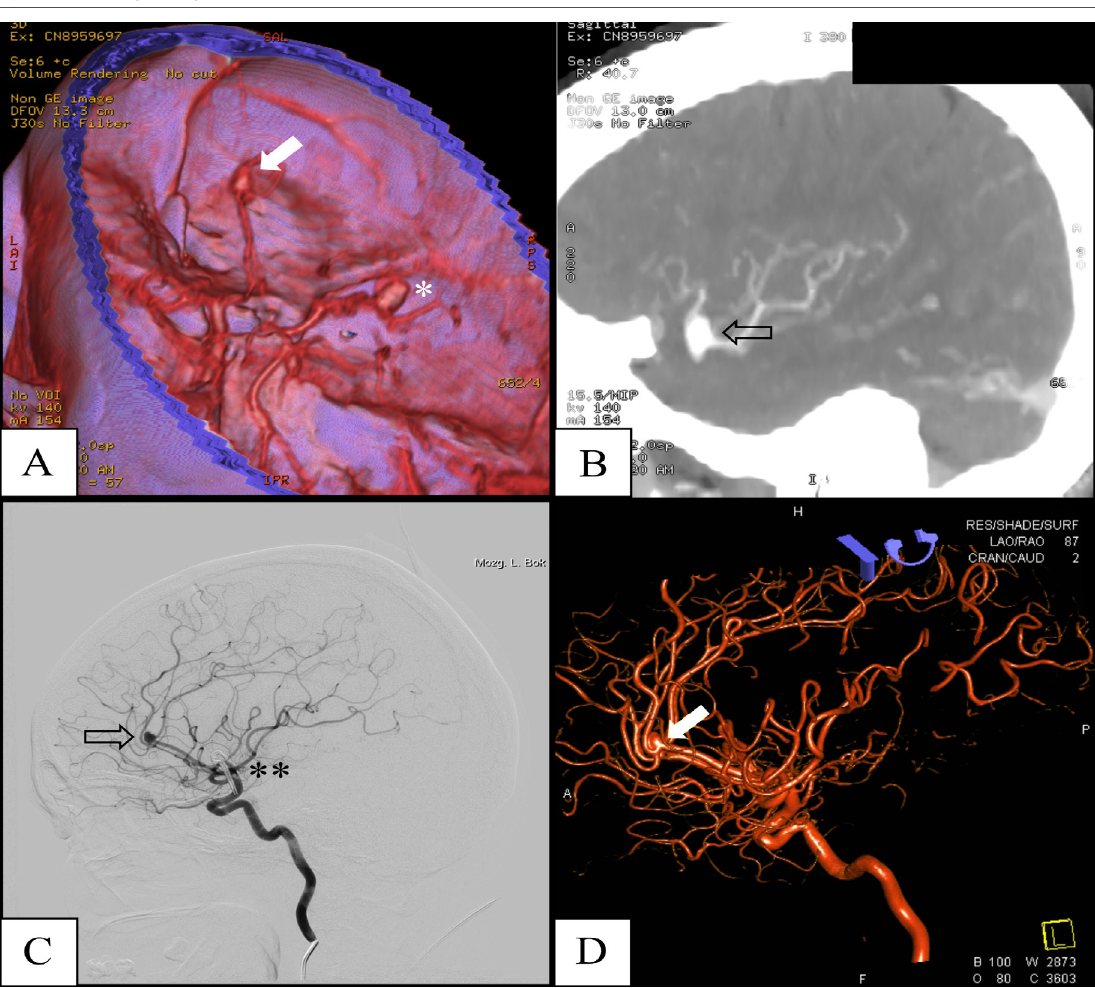
Figure 1. Radiologic Images of the Patient’s